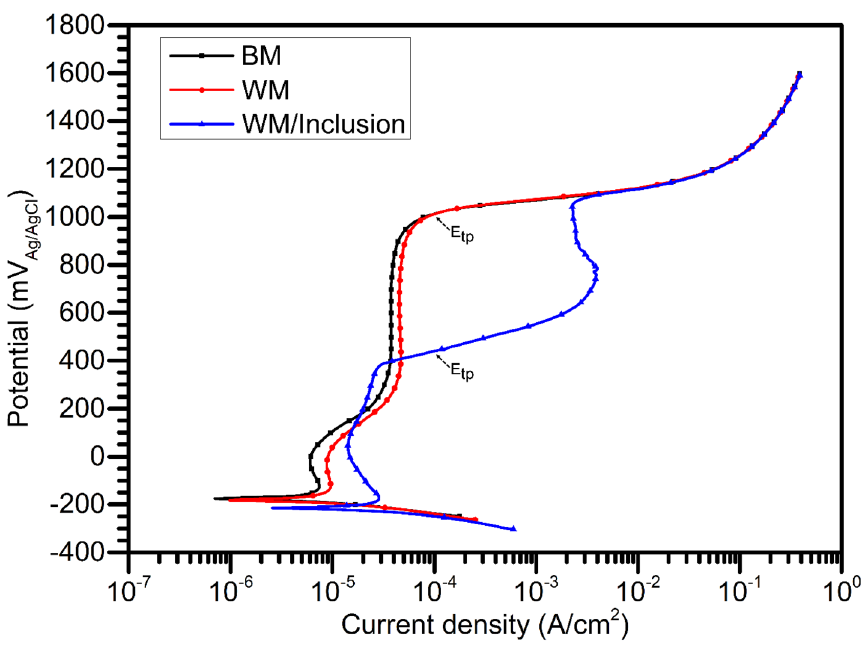
Figure 11. Polarization potentiodynamic curves obtained in 0.5 M H 2 SO 4 solution for the distinct regions of the multi-pass shielded metal arc welded CW6MC butt joint. Table 6. Electrochemical corrosion parameters obtained from potentiodynamic polarization curves in a stagnant and naturally aerated 0.5 M H 2 SO 4 solution at environmental temperature.